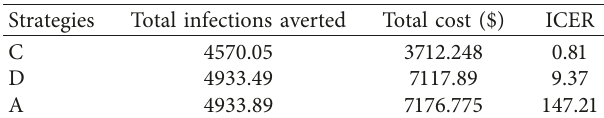
Table 4: Total amount of the infection averted and total cost with their ICER.